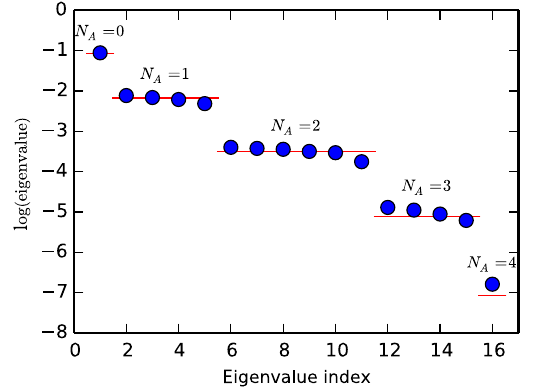
FIG. 2. Eigenvalue spectrum of the reduced density matrix of an infinite temperature eigenstate, ρ boson model Eq. (22), with L ¼ 27 , L The red lines plot the theoretical value of each eigenvalue in the thermodynamic limit, determined from the filling N in which it